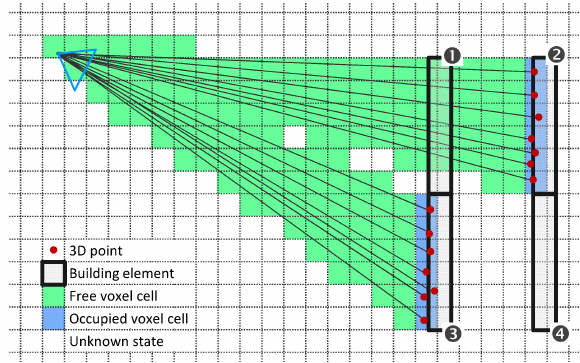
Figure 2. General principle of the visibility checks visualized based on a cross-section through the voxel grid. As example, the rays from one camera to the 3D points reconstructed by this camera are depicted. Voxel cells are labeled as occupied , free or unknown based on this rays.